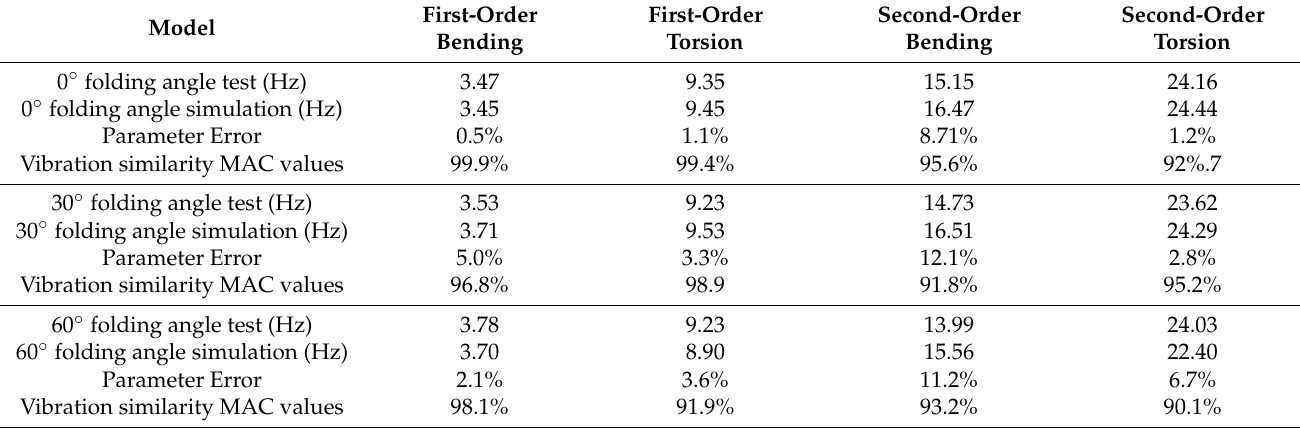
Table 5. Vibration frequencies and their errors under different folding angles of finite element model and experimental model.